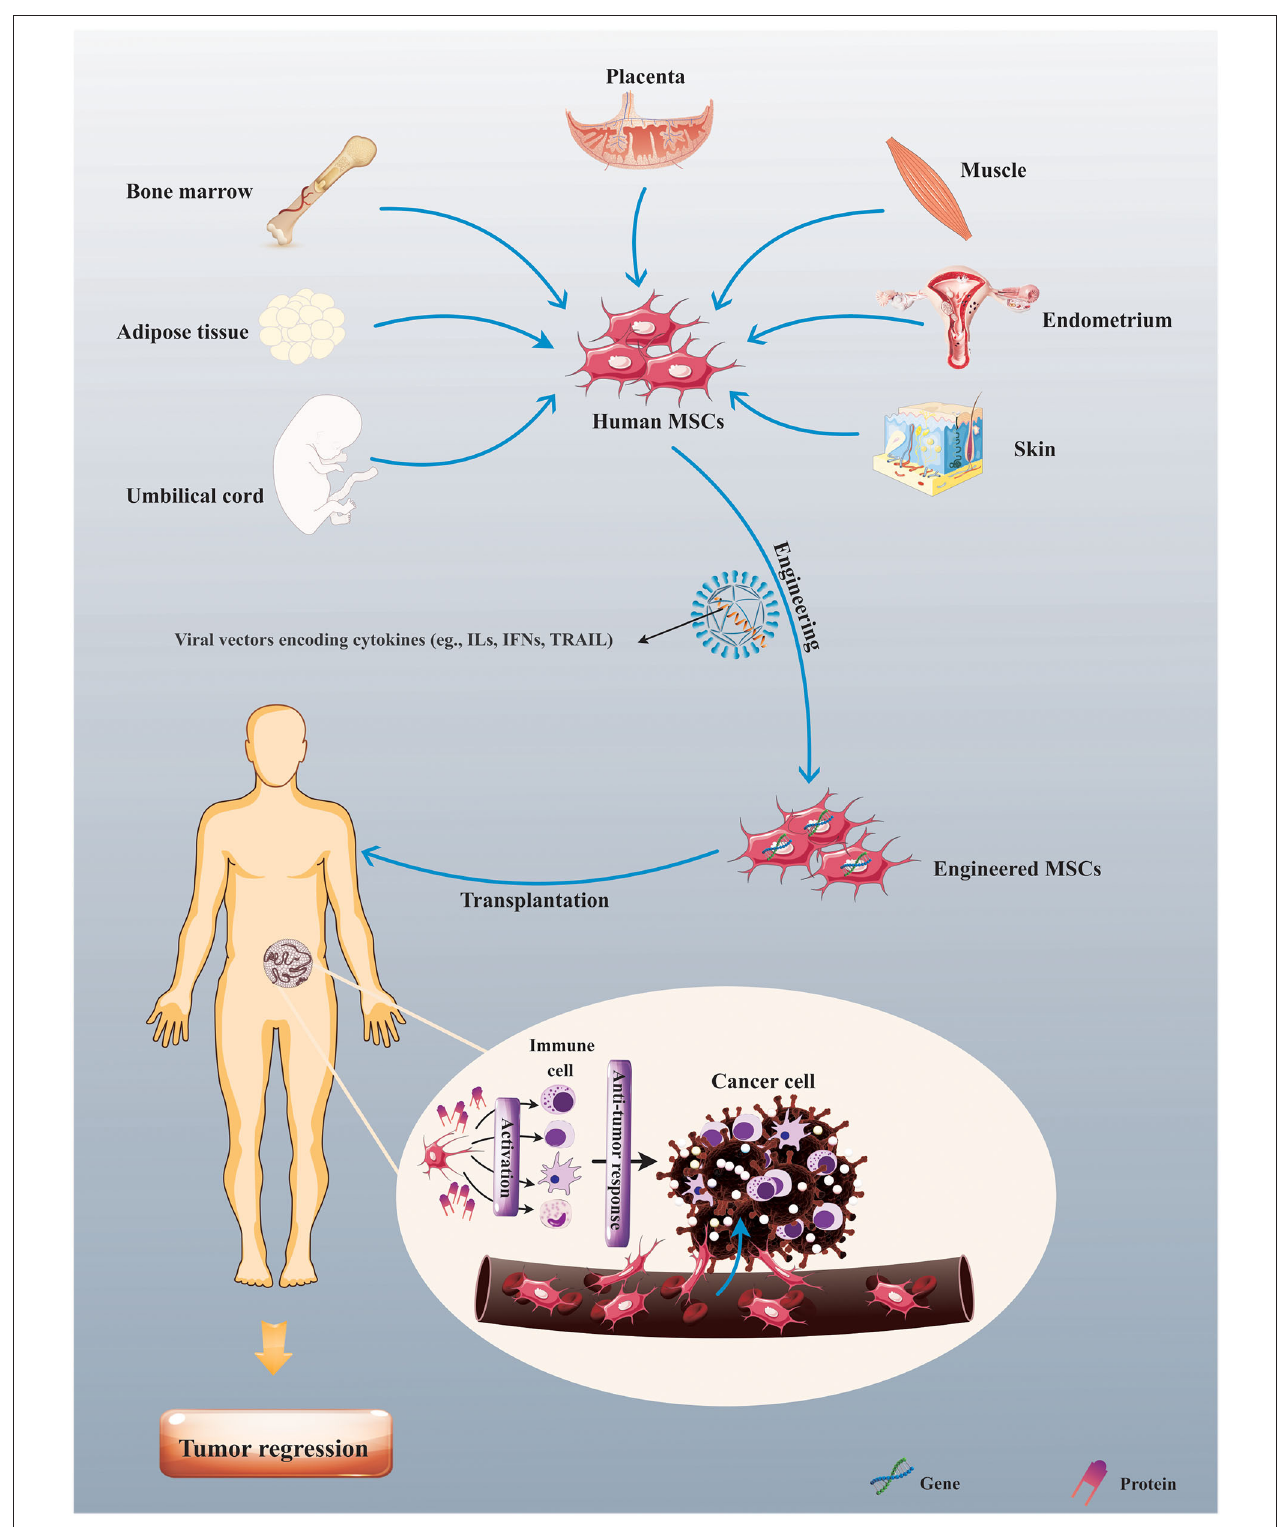
FIGURE 1 | Mesenchymal stem/stromal cell (MSC)-based cytokine delivery for tumor immunotherapy. Human MSCs upon procurement from various sources, such as bone marrow (BM), adipose tissue, and umbilical cord (UC), can be modified to express therapeutic genes (e.g., cytokines) for exerting antitumor response in patients suffering from